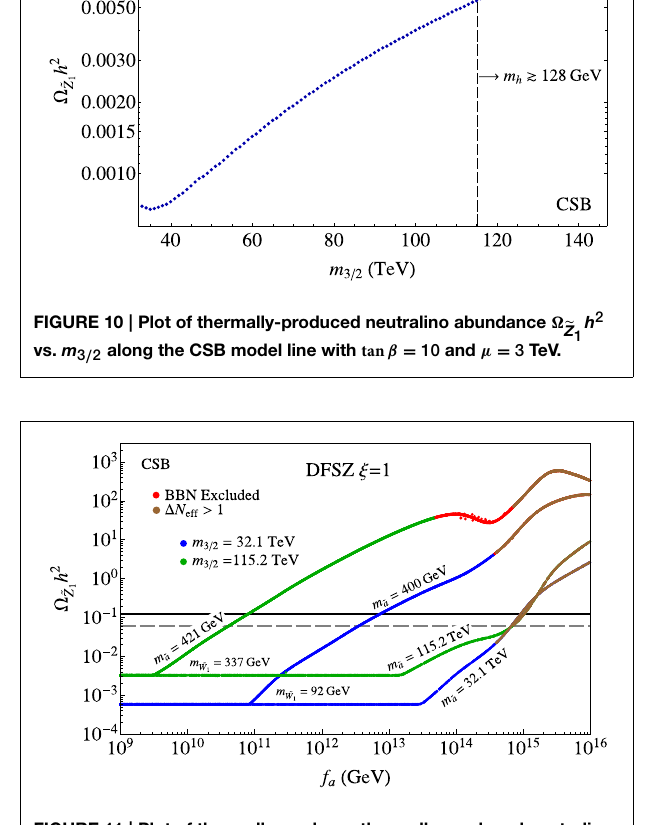
FIGURE 11 | Plot of thermally- and non-thermally-produced neutralino 2 vs. f abundance (cid:127) a along the CSB model line in the DFSZ ξ = 1 Z 1 h case for a light ( m 3 / 2 = 32 TeV, blue envelope) and heavy ( m 3 / 2 = 115 e TeV, green envelope) CSB mass spectrum where m ˜ a ranges from 400 GeV up to m 3 / 2